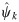
A spike-based grid score for other symmetries.a) Adaptation of the ψ^k score to 4-fold symmetry. Shown above: average over all spikes. b) Adaptation of the ψ^k score to 2-fold symmetry. Shown above: average over all spikes. See text for details.